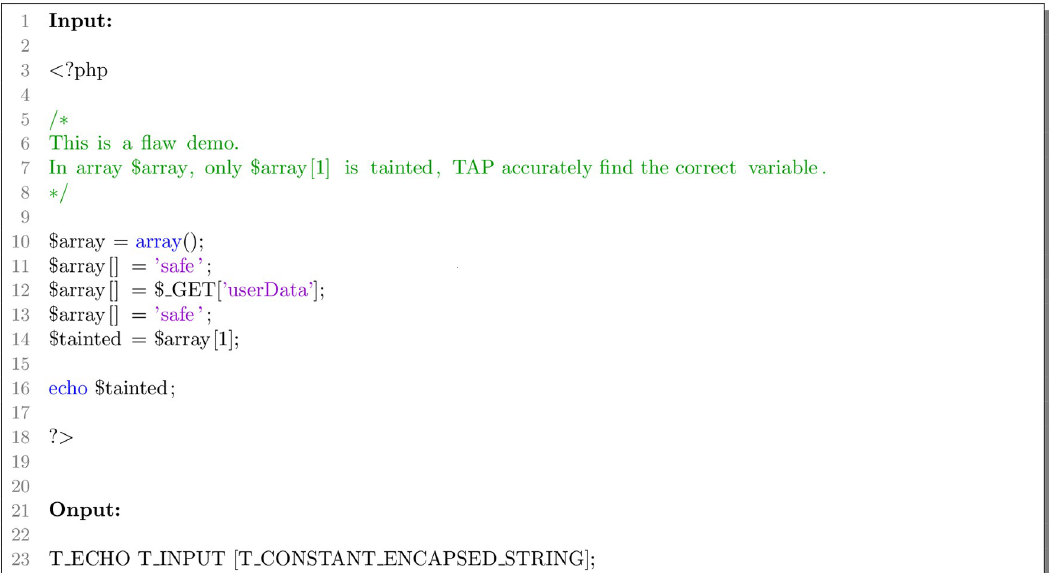
Fig 5. Example of the TAP’s custom